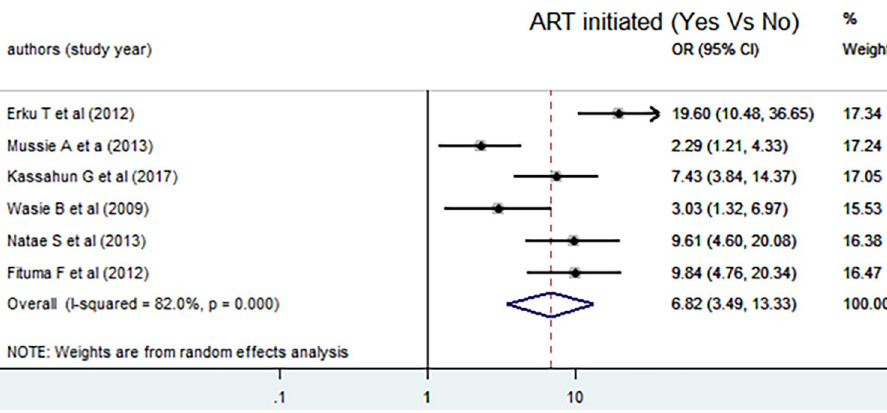
Fig 7. Forest plot of the pooled estimate of the effect of ART initiation on disclosing HIV positive status to sexual partner, a systematic review and meta-analysis, Ethiopia, 2020.